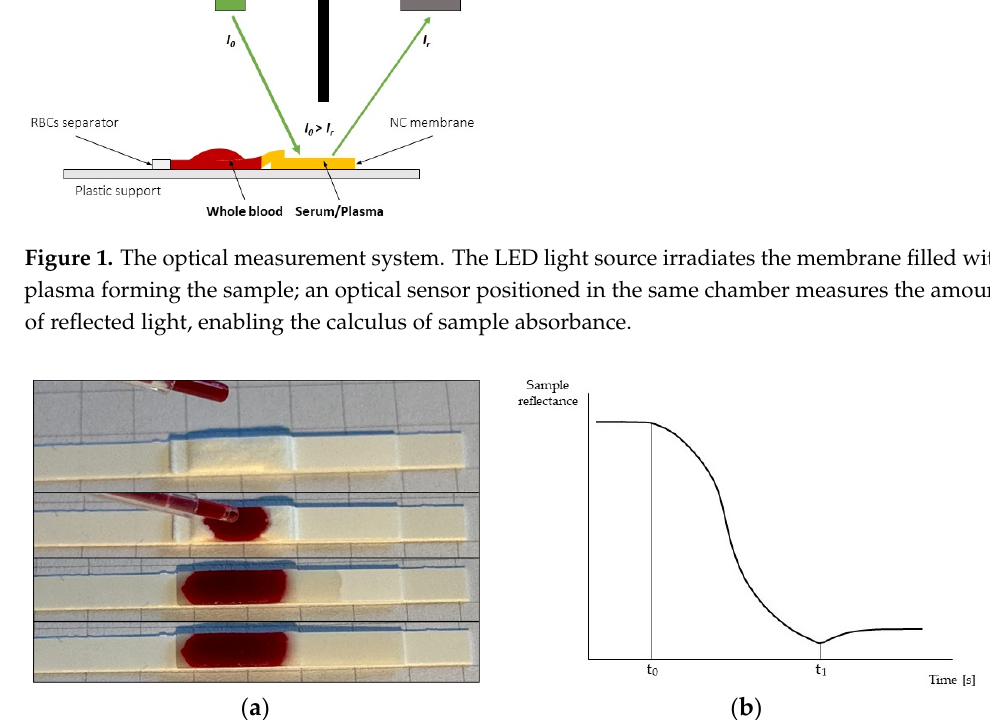
Figure 2. ( a ): from top to bottom, a blank strip having the filter in the center, in contact with the NC membrane extending to the right; the loading instant; plasma entering the membrane; the membrane has been saturated by plasma ( b ): characteristic reflectance-time pattern; t 0 is defined as the instant in which plasma starts filling the NC membrane, associated with a decrease in reflectance; t 1 is defined as the instant in which plasma saturates the NC membrane, associated with a minimum point in reflectance signal. Δ t = t 1 − t 0 .